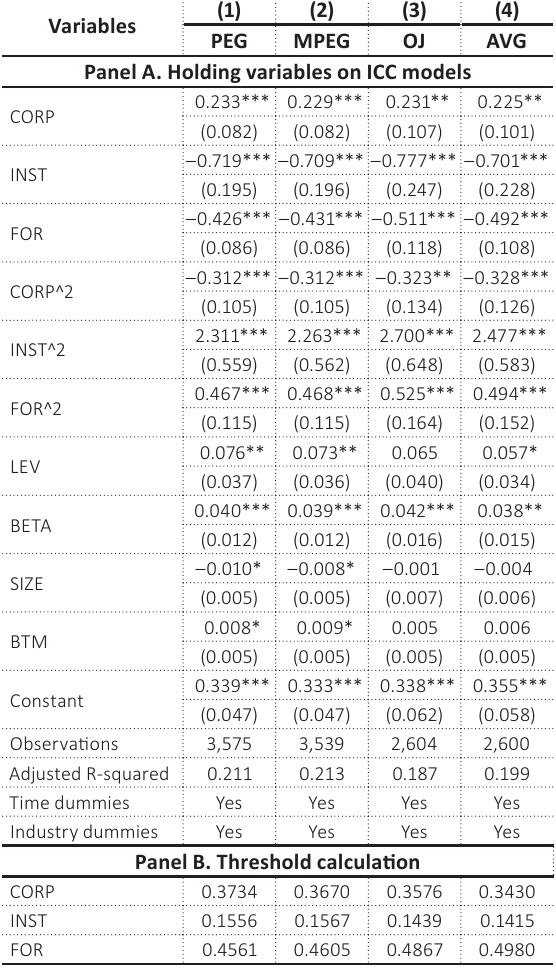
Note: Panel A of Table 2 presents the regression analysis results that examine the nonlinear relationship between holding variables and the ICC models as expressed in Equation 2. The model is estimated with pooled OLS with industry and time dummies. Panel B of Table 2 presents the threshold limits at which the direction of the relationship between holding variables and expected returns changes. The clustered firm-level standard errors are in